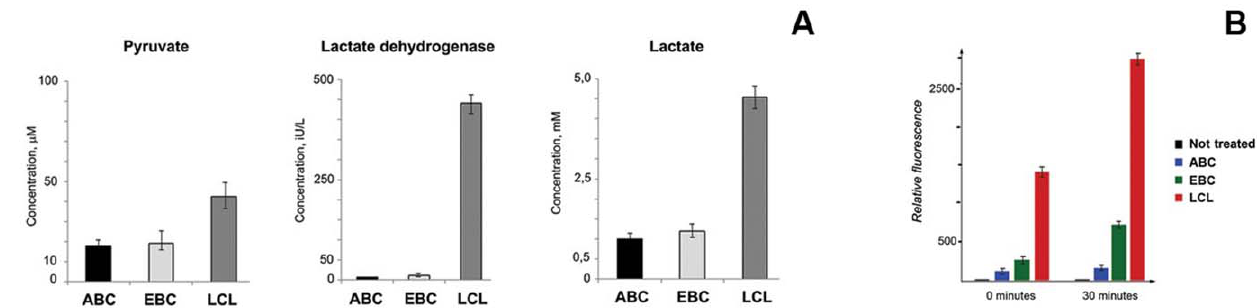
Figure 6. Biochemical analysis of EBV-infected and mitogen-activated B-cells, and LCLs. A – Concentration of pyruvate (left panel), lactate (right panel) and lactate dehydrogenase catalytic activity (middle panel) in CD40 + IL4-activated (ABC), freshly EBV-infected (EBC) B-cells and LCLs. Notice increased values in LCLs compared with CD40 + IL4-activated B-cells, while EBV-infected B-cells showed intermediate values. B – Production of reactive oxygen species in CD40 + IL4-activated (ABC), freshly EBV-infected (EBC) B-cells and LCLs. Notice the increased ROS concentration in LCLs, compared with CD40 + IL4. Freshly EBV-infected B-cells showed intermediate levels of ROS.